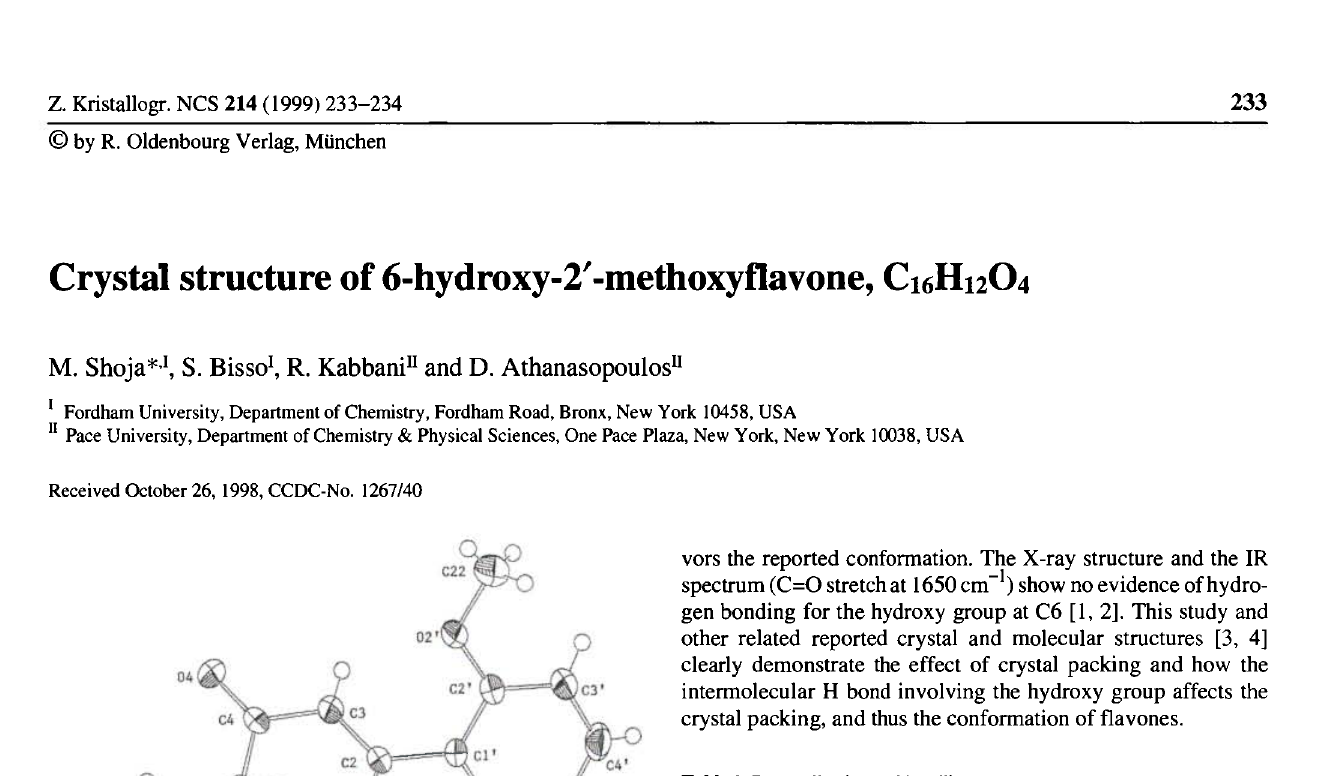
Table 1. Data collection and handling.